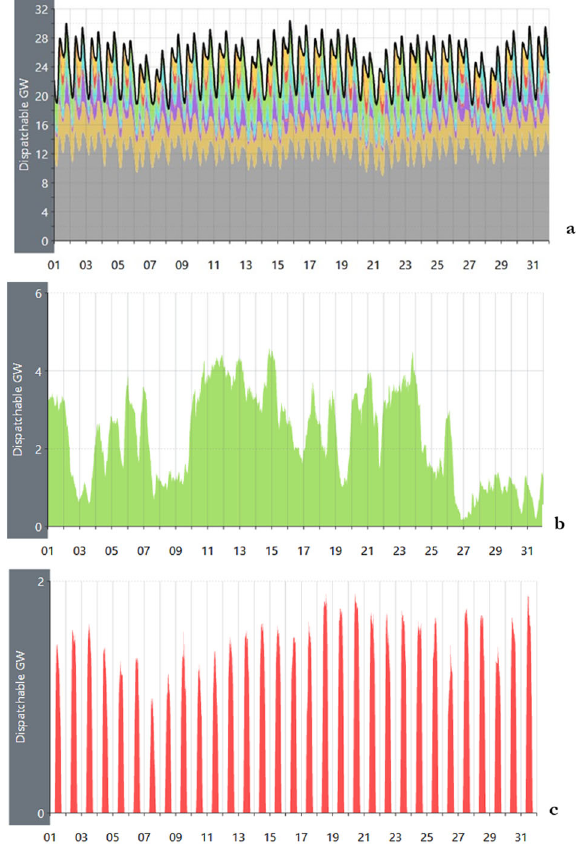
Fig. 1 Contributions of hydro, wind, and solar to the NEM grid. Data from the Australian Government Department of the Environment and Energy (2019).